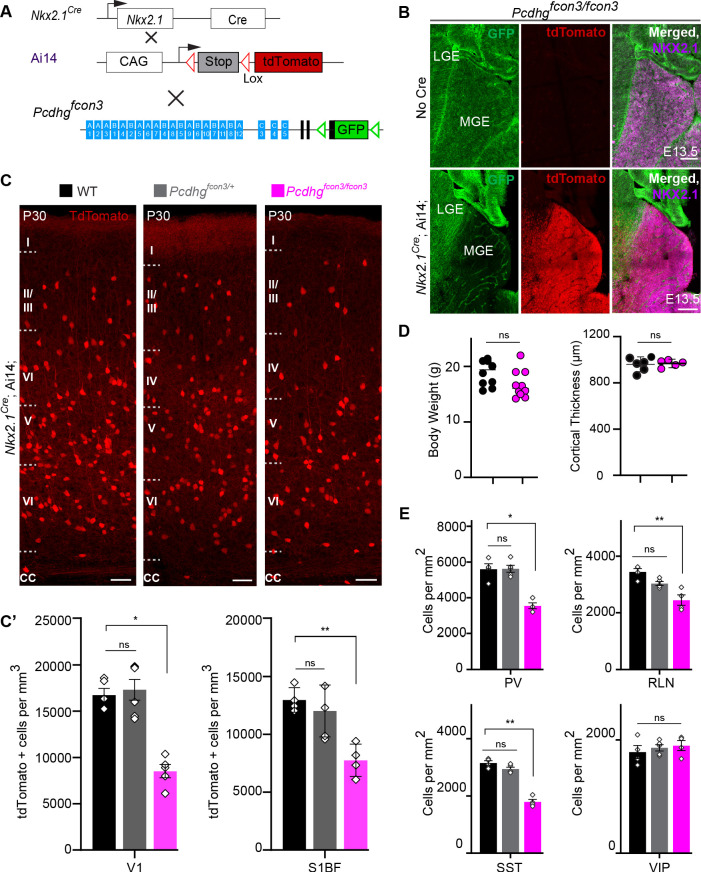
Loss of Pcdhg genes targeted to Nkx2.1 expressing cells results in selective loss of cIN derived from the MGE.( A) Mutant mice with loss of Pcdhg in MGE-derived cIN were generated by crossing Pcdhgfcon3 mice to Nkx2.1Cre mice. The conditional Ai14 line was used to fluorescently label MGE-derived cells. (B) Pcdhgfcon3/fcon3 mice (at E13.5; top panels) carrying the Pcdhg mutant allele, but not Cre, show robust expression of GFP in the MGE. In contrast, in Nkx2.1Cre;Ai14;Pcdhgfcon3/fcon3 mice (at E13.5; bottom panels), carrying the Pcdhg mutant allele and expressing Cre, GFP expression was eliminated from the MGE. Note NKX2.1 staining (magenta) in the panels on the right delineates MGE/POA (preoptic area). The few cells left expressing GFP in the MGE are blood vessels and are tdTomato negative. (C) Photographs of coronal sections of the primary visual cortex (V1) in Nkx2.1Cre;Ai14;Pcdhg+/+ (Pcdhg WT), Nkx2.1Cre;Ai14;Pcdhgfcon3/+ (Pcdhg HET) and Nkx2.1Cre;Ai14;Pcdhgfcon3/fcon3 (Pcdhg mutant). Scale bar, 100 μm. (C’) Quantification of the density of tdTomato+ cells in V1 and S1BF cortex of P30 Nkx2.1Cre;Ai14;Pcdhg WT (black), Pcdhg HET (grey) and Pcdhg mutant (magenta) mice. The number of Nkx2.1-derived cells was significantly reduced in Nkx2.1Cre;Ai14;Pcdhg mutant mice compared to WT controls(Kruskal-Wallis test; for V1(P value=0.002), for S1BF (P value=0.0065), adjusted p values *p=0.0232, **p=0.0168 (S1), n = 4–6 mice of each genotype). (D) Body weight and cortex thickness measurements in Nkx2.1Cre;Ai14;Pcdhg WT (black) and Pcdhg mutant (magenta) mice at P30. Body weight and cortical thickness were not significantly affected by loss of Pcdhg (Mann-Whitney test, body weight (p=0.0547, n = 10 mice of each genotype), cortical thickness (p=0.2857, n = 4–5 mice of each genotype). (E) Quantification of tdTomato+ cIN subtypes in V1 mouse cortex at P30. Nkx2.1Cre;Ai14;Pcdhg mutant mice (magenta) had significantly reduced numbers of MGE-derived parvalbumin (PV)+, somatostatin (SST)+, and Reelin (RLN)+ cells compared to WT controls. In contrast VIP+ cells, which are derived from the CGE, were not significantly affected (Kruskal-Wallis test; for PV (P value = 0.0113), for SST (P value=0.0009), for RLN (P value = 0.0014), and for VIP (P value=0.636); adjusted p values *p=0.0113 (PV), **p=0.0055 (SST), **p=0.0055 (RLN), n = 4–5 mice of each genotype).
Figure 3—source data 1.Quantification of Nkx2.1-derived cINs, body weight and cortical thickness measurements in controls and Pcdhg-deficient mice.